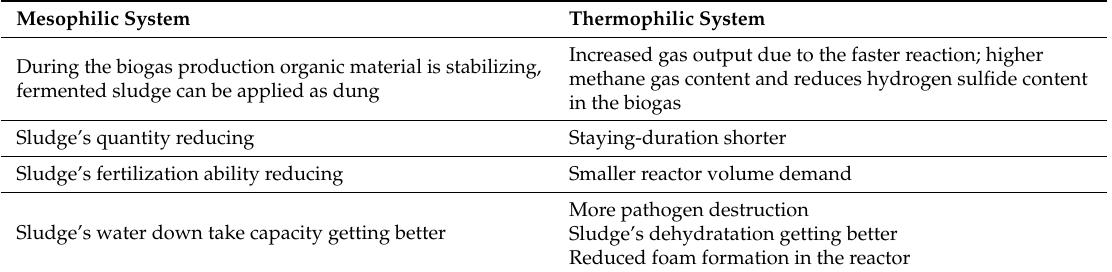
Table 3. Corresponding advantages of mesophilic and thermophilic digestion systems. Source: [24]. Mesophilic System